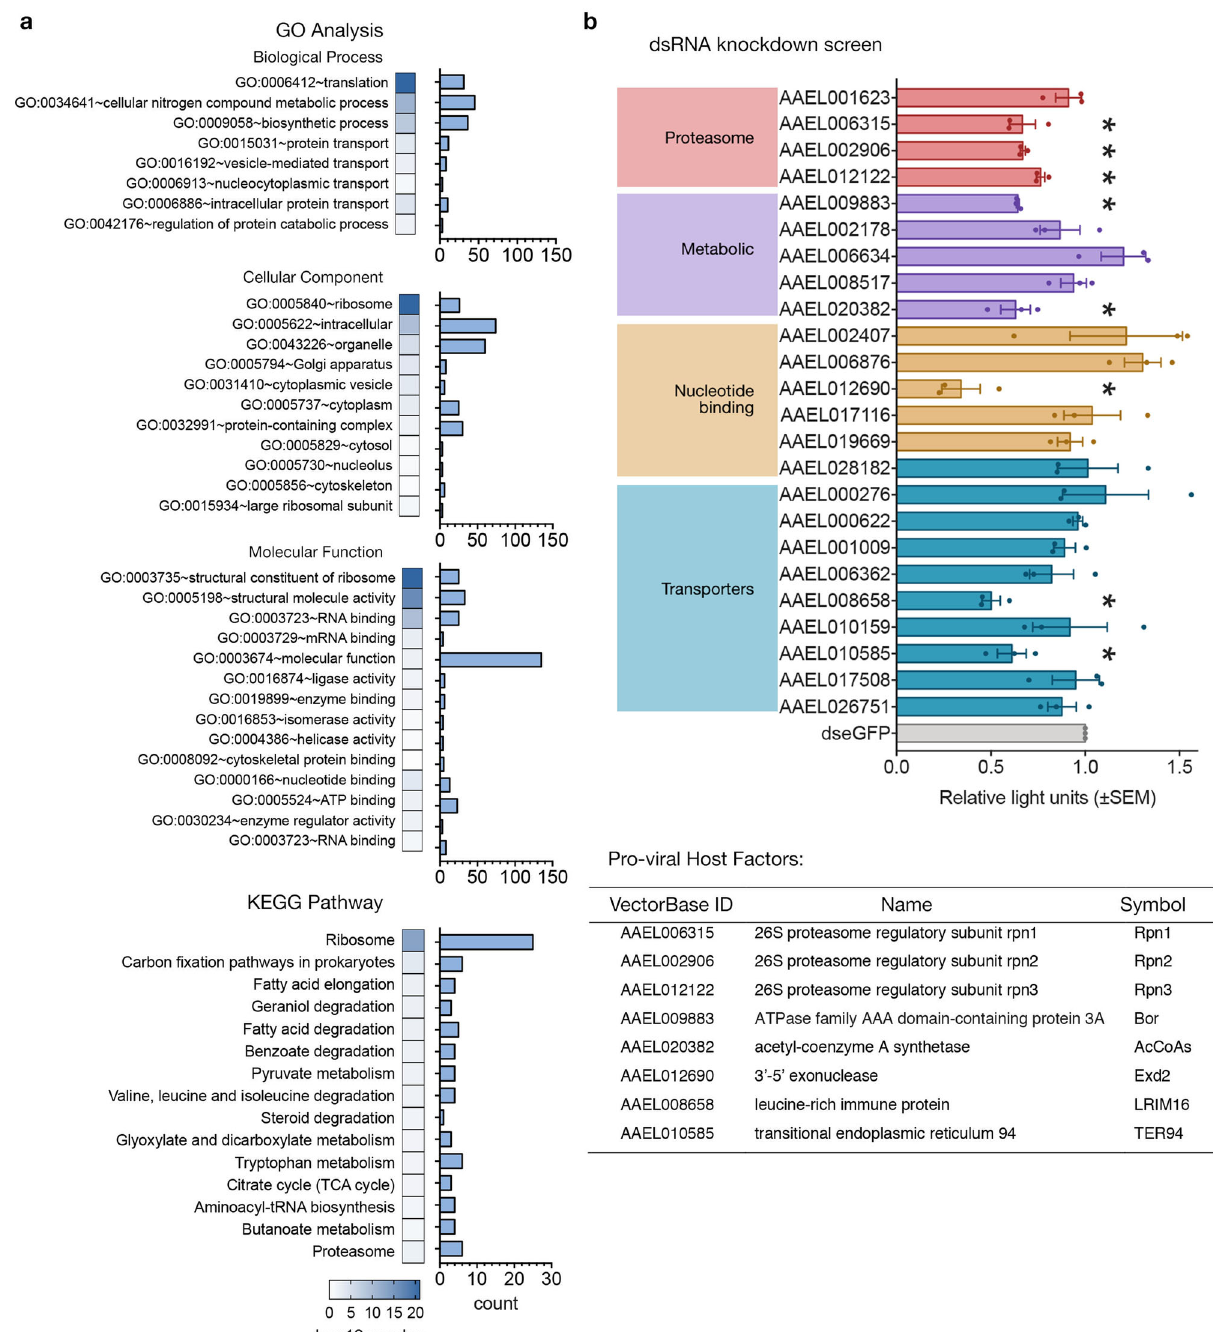
Fig. 2 ZIKV capsid interactors and dsRNA knockdown screen. a GO and KEGG pathway enrichment analyses of annotated interactors performed in VectorBase and DAVID. Heat map shows signi fi cant enrichments ( p -value < 0.05 in − log10) with Benjamini correction against the background gene set with actual p -values provided in the Source Data fi le. Bars indicate gene count. b dsRNA knockdown screen of 24 interactors (Supplementary Table 3) in AF5 cells with ZIKV-NLuc (MOI = 1) infection 24 hpt for 72 h. NLuc levels presented as mean ± SEM light units relative to dseGFP controls set to 1 from n = 3 independent repeats. * p -value < 0.05 determined by two-tailed Student ’ s t -test, where vs. DMSO controls: AAEL006315 p = 0.041; AAEL002906 p = 0.002; AAEL012122 p = 0.008; AAEL009883 p = 0.001; AAEL020382 p = 0.042; AAEL012690 p = 0.023; AAEL008658 p = 0.009; AAEL010585 p = 0.037; other p -values provided in the Source Data fi